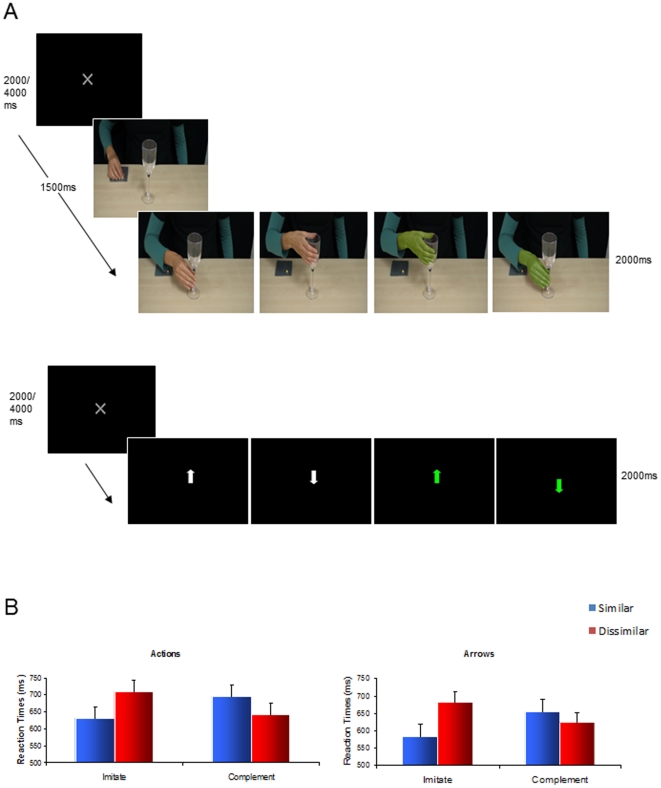
Trial sequences and behavioural results.A: Possible sequence of events in a given trial during the Actions (top) and Arrows (bottom) conditions. B: Reaction times (ms) for similar and dissimilar responses during Actions (left) and Arrows (right) conditions.